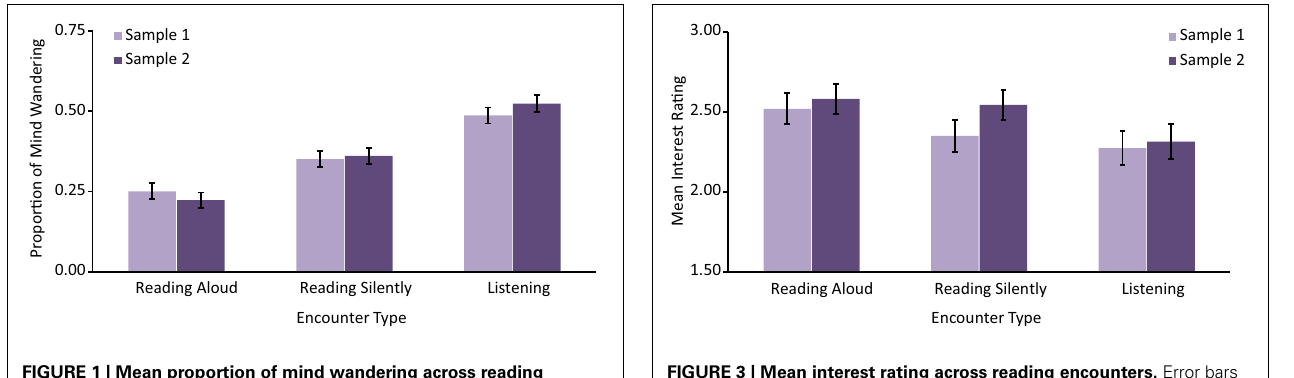
FIGURE 3 | Mean interest rating across reading encounters. Error bars represent one standard error of the